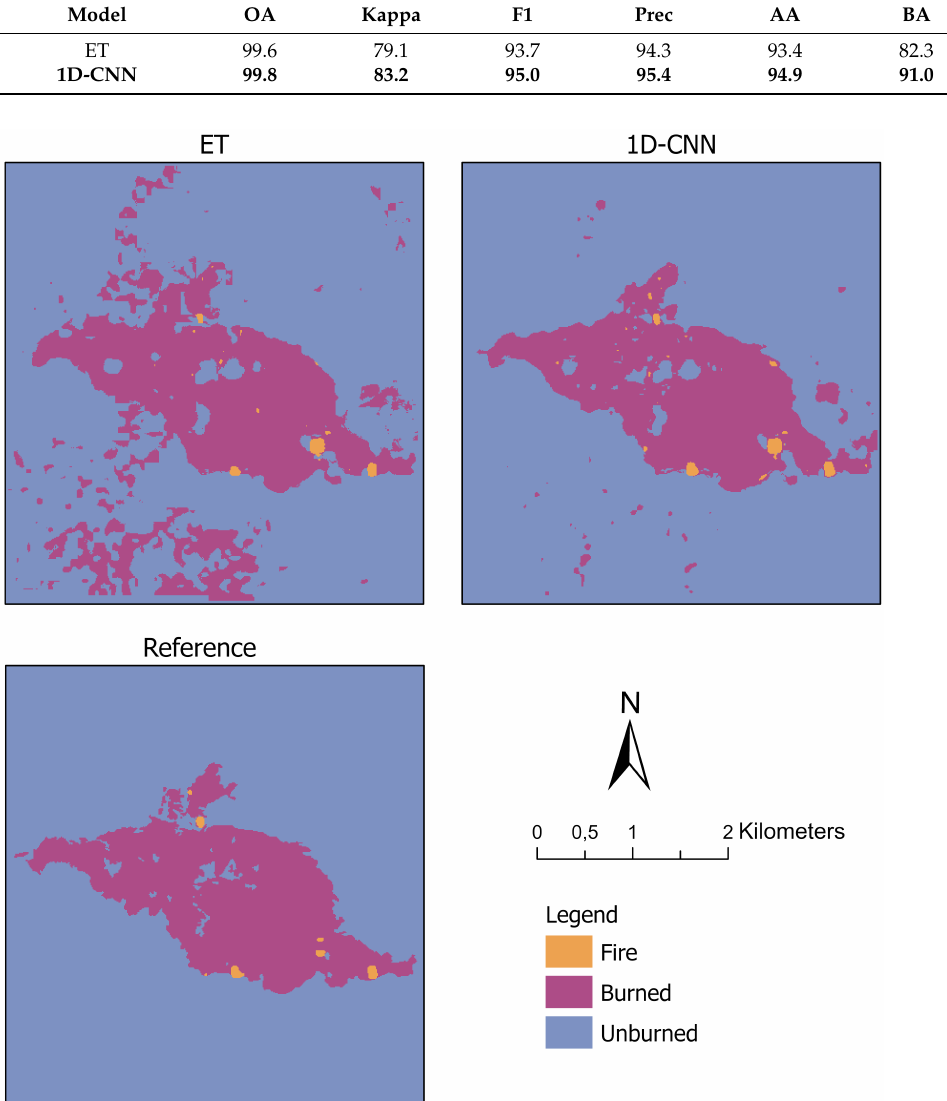
Figure 12. Visualization of the classification results of extremely randomized tree (ET) ( top left ) and the 1D convolutional neural network (1D-CNN) ( top right ) on the independent test region in Spain. The visualization of the generated reference data is given on the bottom . Projection: Transverse